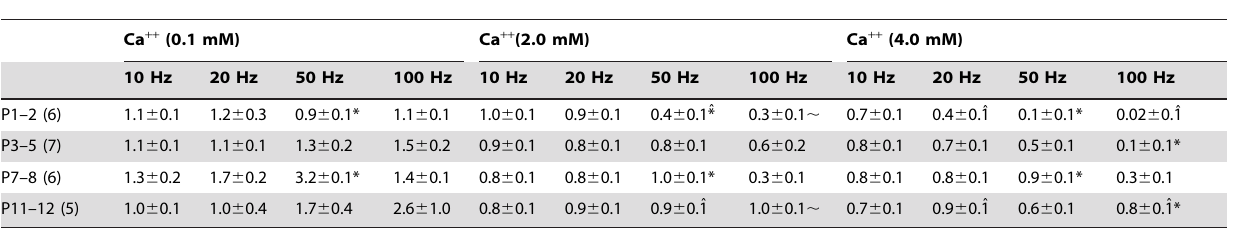
Table 1. Paired pulse ratios for GABA/gly component.